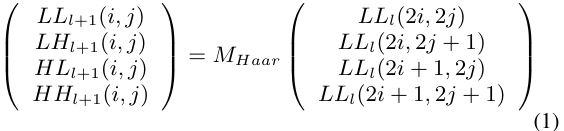
Figure 1: Haar wavelets transform and edge maps The Haar decomposition of an image I is defined